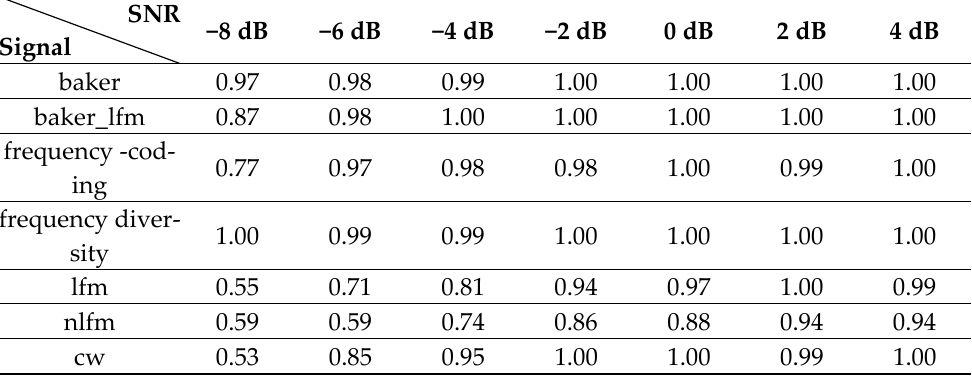
Table A1. Recognition results of one-dimensional DRSN under Gaussian noise.